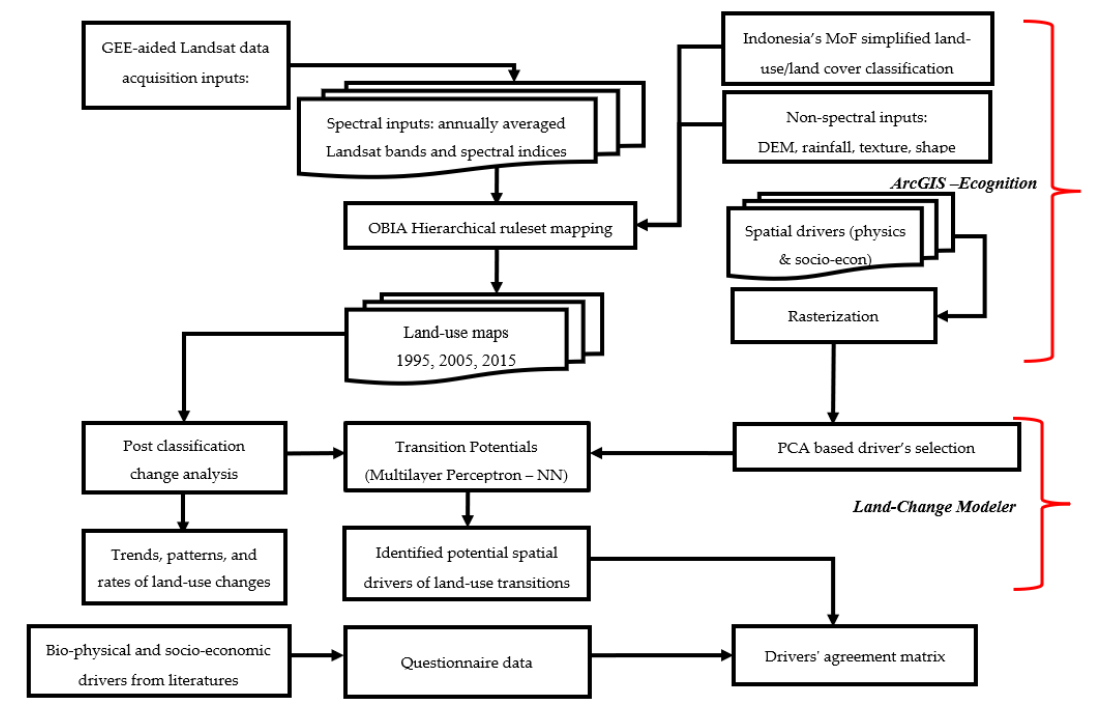
Figure 2. Methodological approach for the study. Table 1. Land-use classification scheme (adapted from Indonesia Ministry of Forestry,